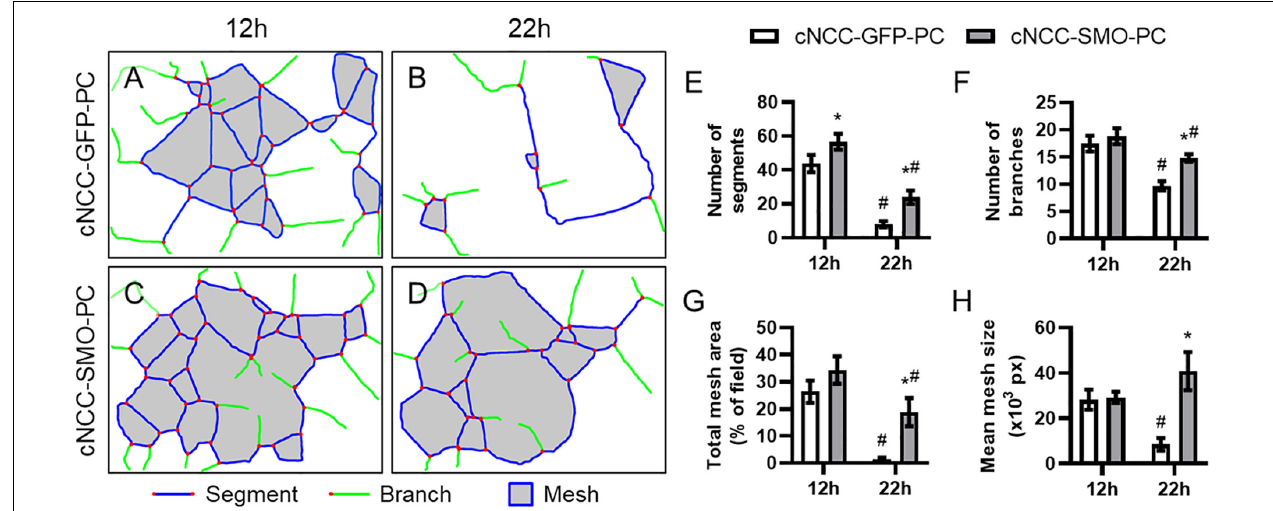
FIGURE 6 | Cell-autonomous Shh pathway activation in cNCC-derived pericytes promotes endothelial cord stability. (A–D) Cord network schematics of HUVEC and control cNCC-GFP-PC or Shh pathway-activated cNCC-SMO-PC co-cultures were generated from images taken at 12 and 22 h. Blue lines are segments, green lines are branches, red dots are junctions, and filled gray areas are meshes. Images are representative of 11 biological replicates per group. (E–H) Number of segments, number of branches, total mesh area, and mean mesh size were measured by the Angiogenesis plugin for ImageJ for the indicated groups at 12 and 22 h. * p < 0.05 between co-cultures at the same time point, # p < 0.05 of the indicated co-culture at 22 h compared to the same co-culture at 12